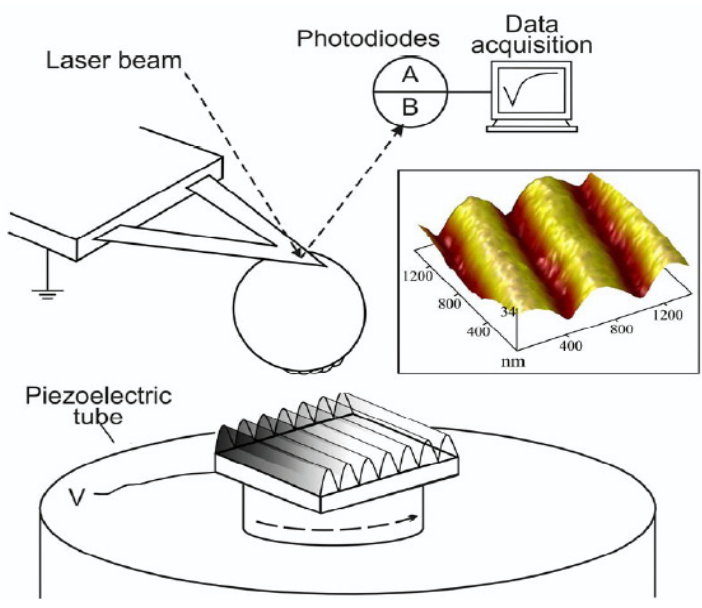
Figure 4. Schematic diagram of the experimental setup using an atomic force microscope for measuring the normal Casimir force between corrugated surfaces (see the text for further